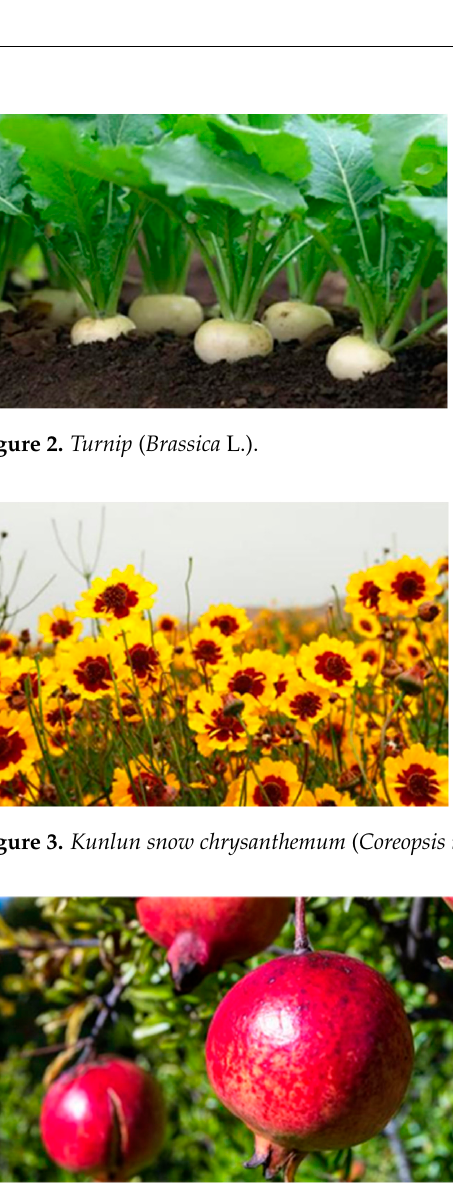
Figure 5. Mulberry ( Morusalbal .).